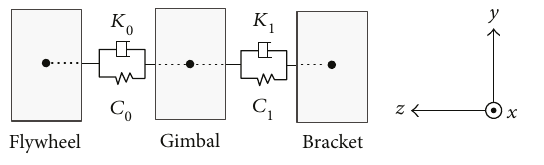
Figure 7: Simpli fi ed model of CMG. Figure